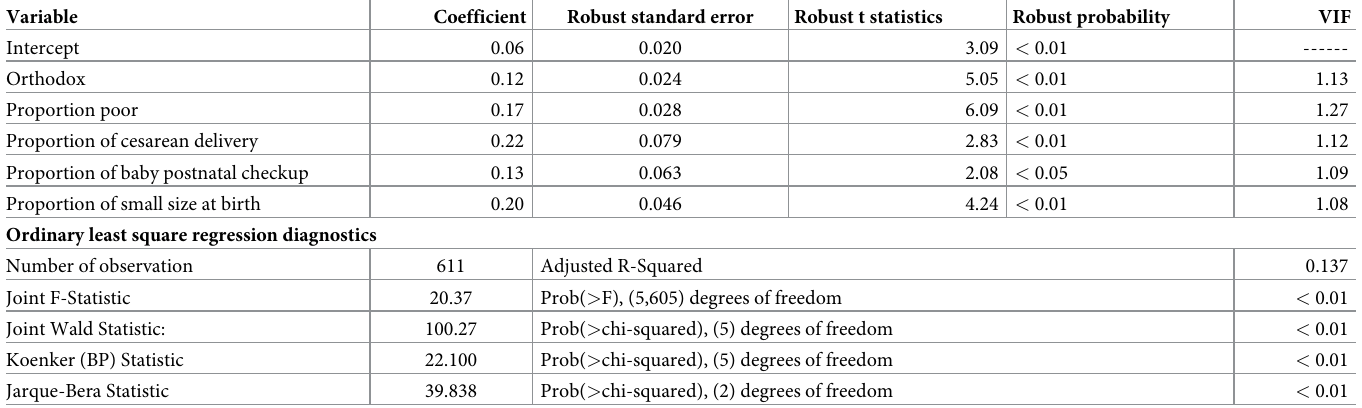
ducted in Uganda [10], Bangladesh [32], Ethiopia [23], and South Sudan [14]. These disparities could be explained by differences in study participants’ health-care utilization, culture, and socioeconomic status. Across region highest and the lowest proportion of delayed Table 2. Summary of ordinary least squares